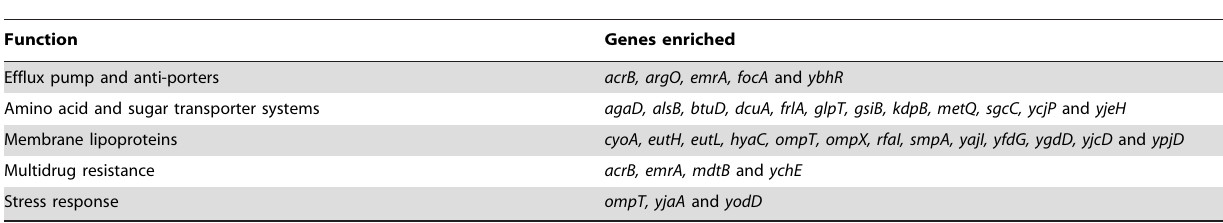
Table 1. Membrane related genes enriched in the n-butanol